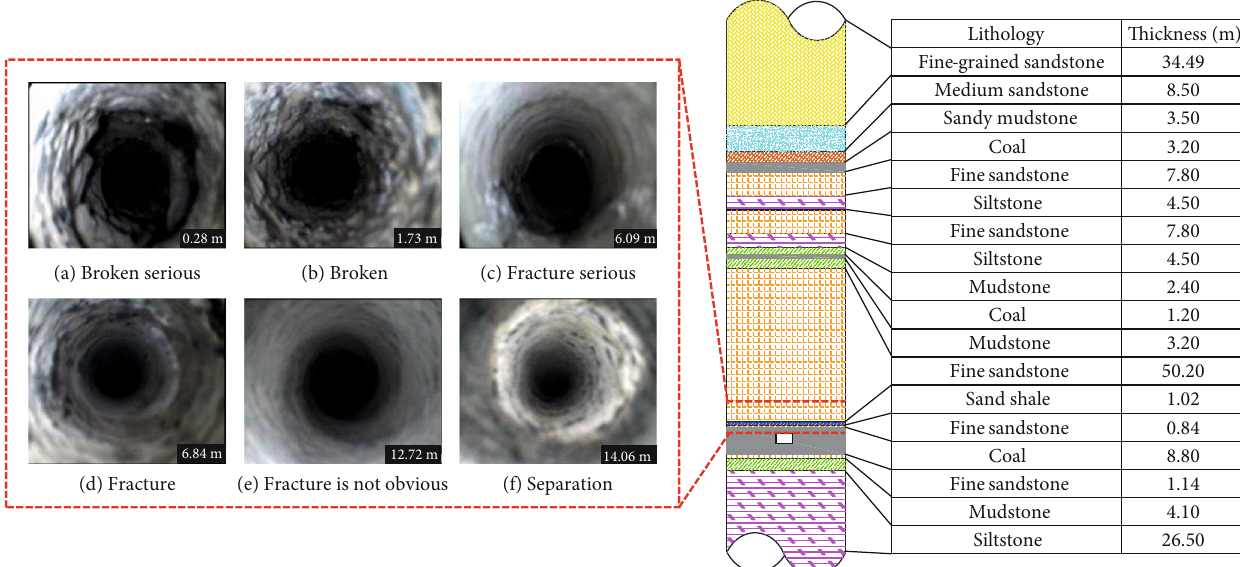
Figure 2: Observation of surrounding rock state at di ff erent depths by borehole